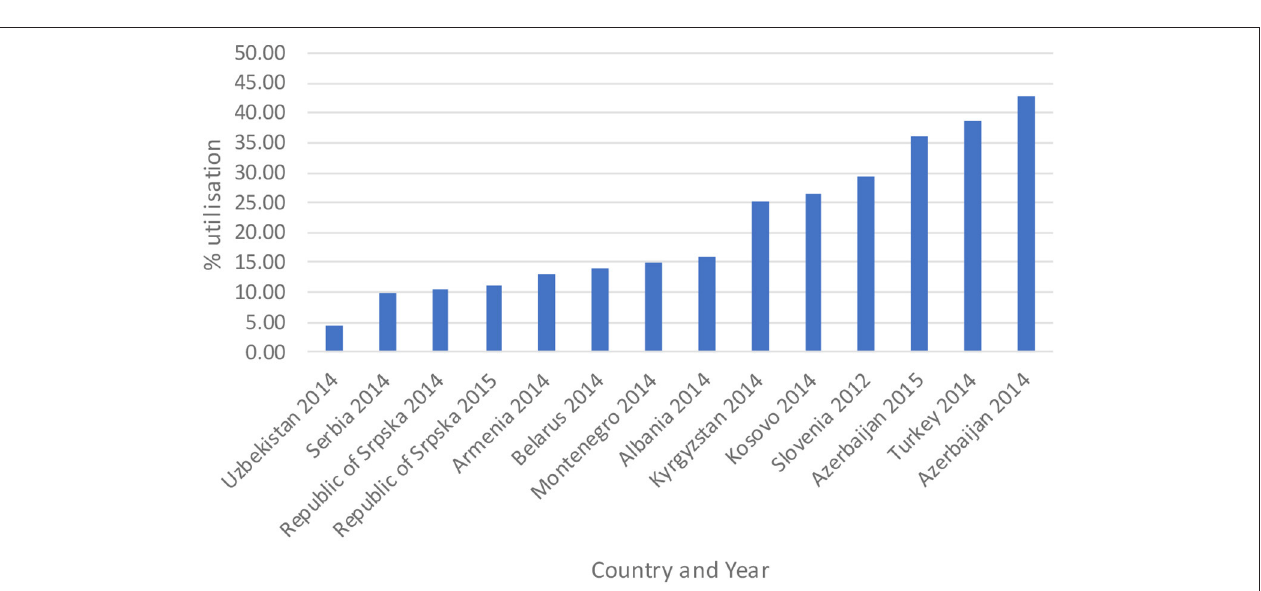
FIGURE 5 | Percentage combination penicillins (co-amoxiclav J01CR02) as a % of total antibiotic utilization (taken from Fürst et al., 2015; WHO EUROPE, 2017; ECDC, 2018).